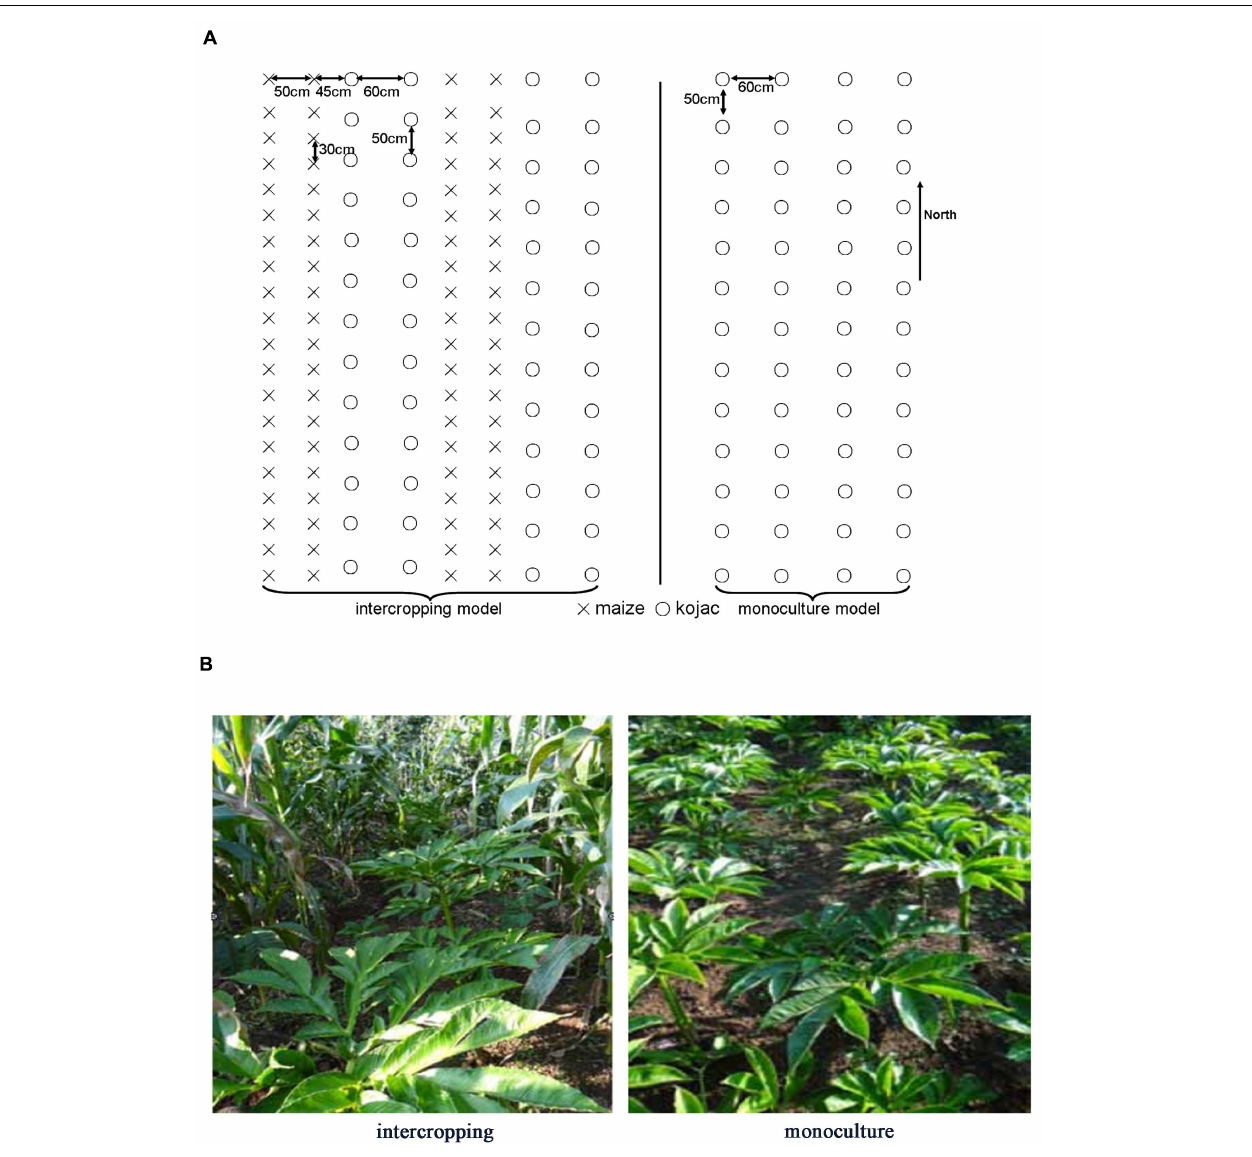
FIGURE 1 | (A) Experimental design for the intercropping and monoculture of Amorphophallus xiei . In the monoculture system, the distance between rows and plants was 60 and 50 cm, respectively. In the intercropping system, two rows of A. xiei were intercropped with two rows of maize. The row and plant distance for A. xiei under the intercropping system was the same as in the monoculture system. In the intercropping system, the distance between rows of A. xiei and rows of maize was 45 cm, and the row and plant distance for maize was 50 and 30 cm, respectively. The circles represent the A. xiei , crosses represent the maize. (B) The landscape of shade-demanding crop Amorphophallus xiei grown in intercropping and monoculture systems. The two crops involved in the intercropping system are konjac and maize.